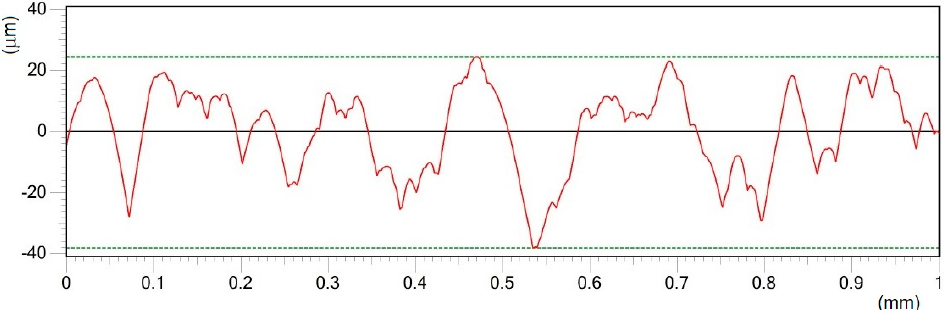
Figure 9. Roughness profile of surface D in Y direction treated by pulse energy of 0.8 mJ; Ra 11.43 μ m.